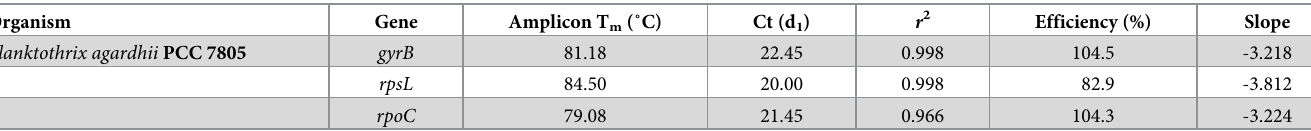
Table 5. qPCR related parameters for three genes of Planktothrix agardhii PCC 7805 studied. The Ct values for the first dilution (d 1 ) of the standard curve are given.